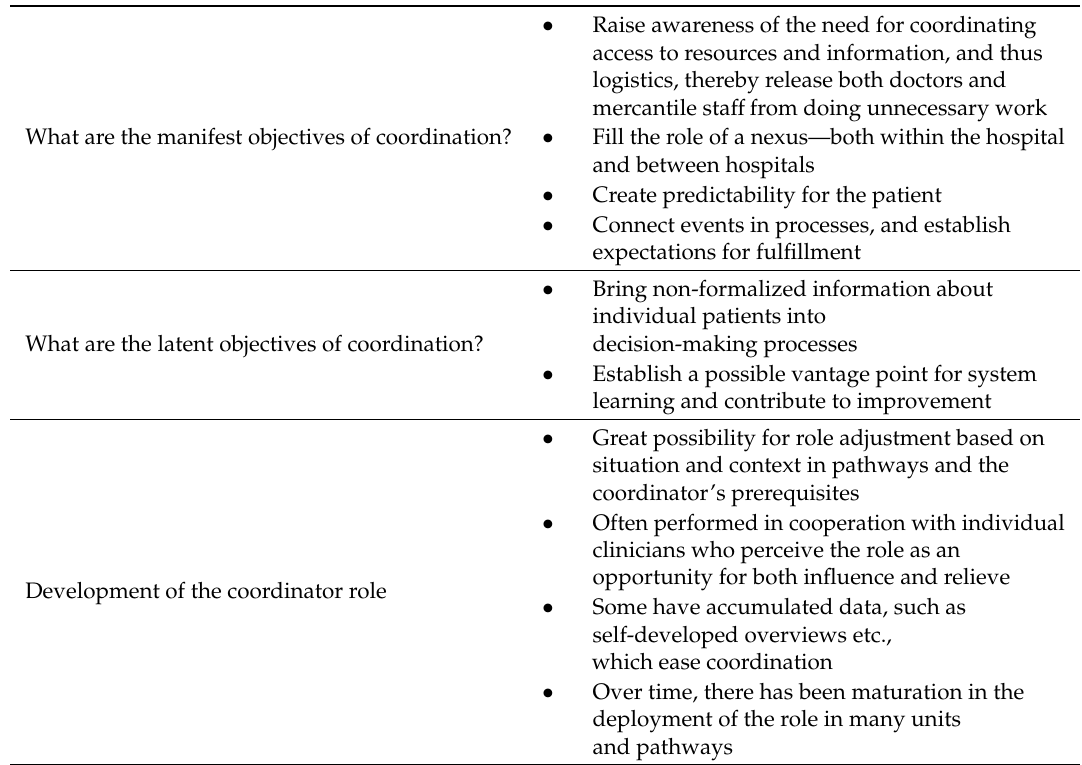
Table 7. Coordination activities by patient pathway